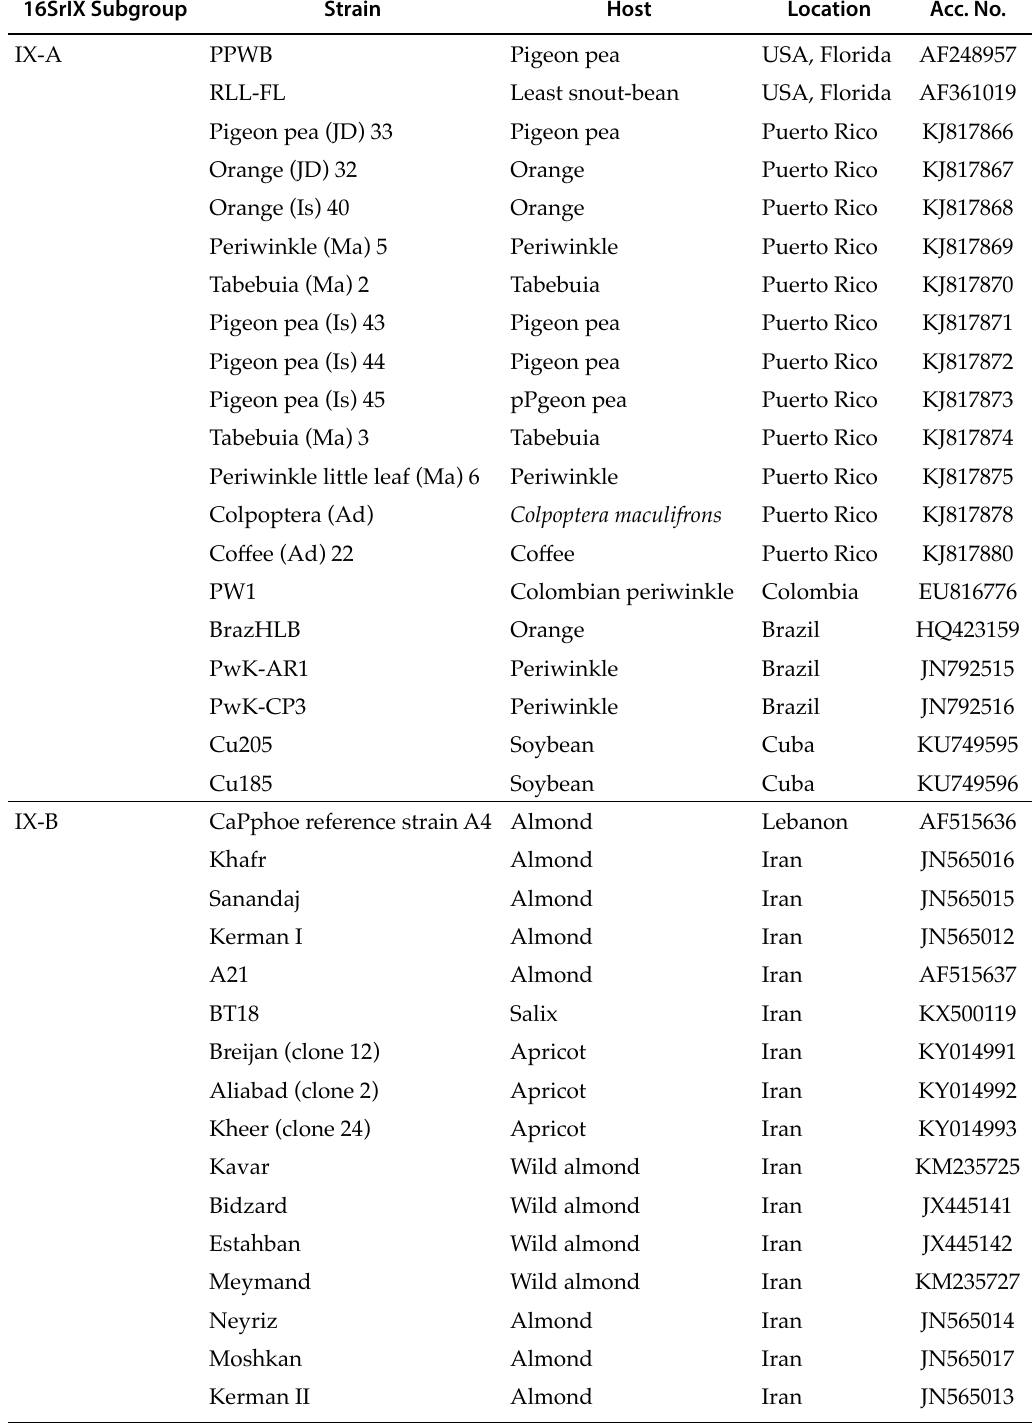
Table 1. Phytoplasma strains in ribosomal group 16SrIX employed for 16S rDNA nucleotide sequence